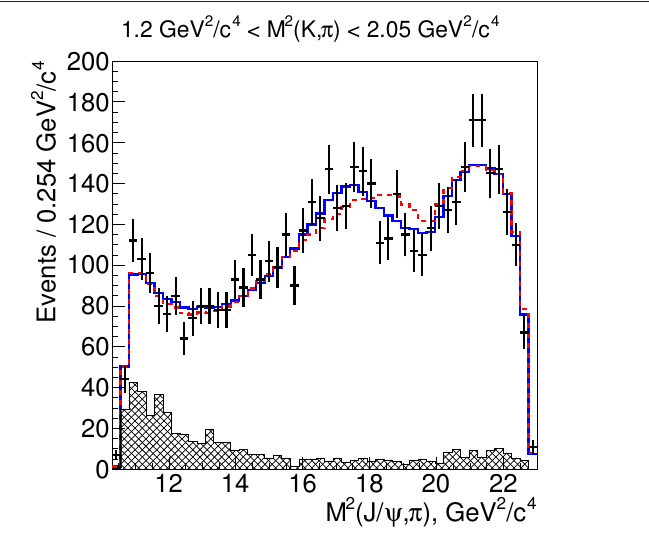
Figure 2. Projections of the ¯ B 0 → J /ψπ + K − fit results onto M 2 the data, the hatched histogram is the background, the blue solid line is the fit with the Z c (4200) + , and the red dashed line is the fit without its contribution. The region with 1 . 2 < M 2 selected. Figure from reference